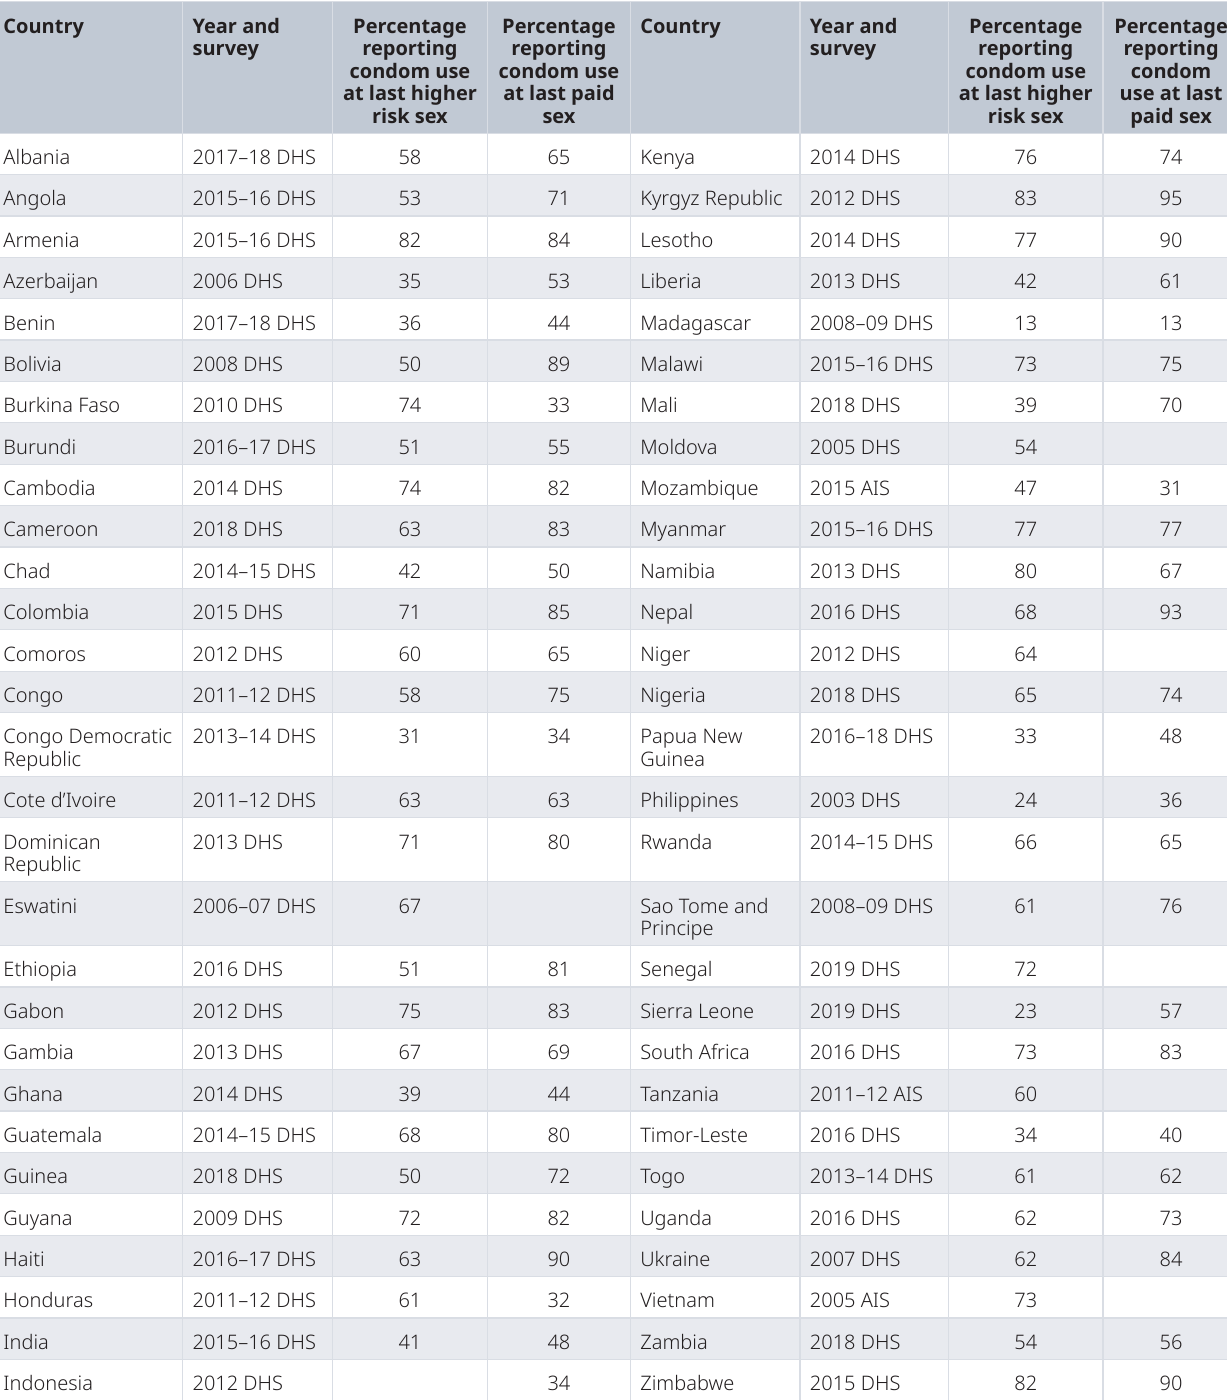
Table 1. Reported rates of condom use at last sex with a higher risk partner and with a sex worker.